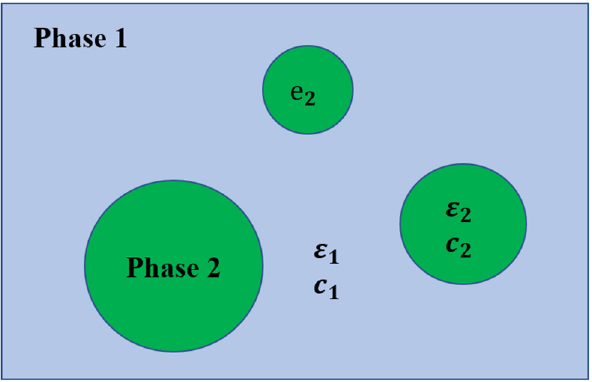
Figure 2. Two-phase system composed of a non-piezoelectric continuous phase (Phase 1) and a piezoelectric spherical phase (Phase 2). Reprinted with permission from ref. [87]. Copyright 1973 John Wiley & Sons, Inc.